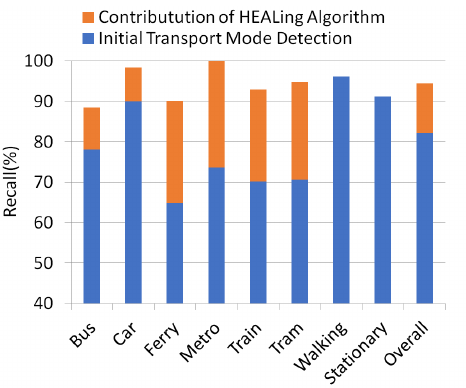
Figure 11. Contribution of the Healing algorithm to the recall of initial transport mode